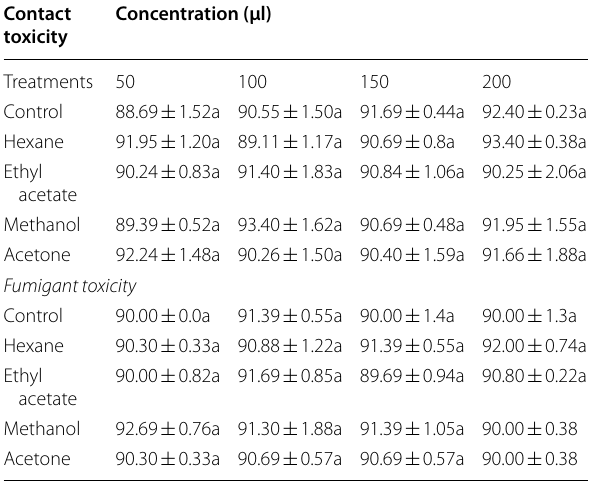
Means within a column followed by different letters are significantly different ( P > 0.05%), Tukey’s Student test (HSD)